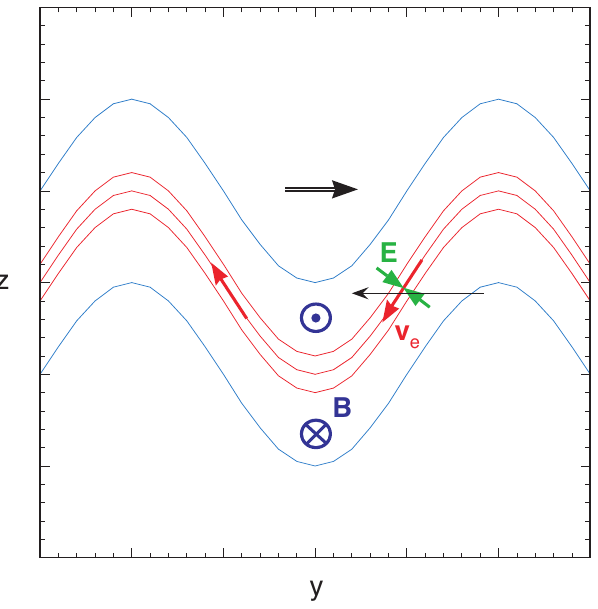
Fig. 2. Thin current sheet embedded in a wider current sheet which undergoes a kink mode propagating in y, as indicated by the double arrow. The red arrow indicates the fast electron drift in the em- bedded current sheet. The green arrows indicate the electric field associated with that drift. The blue circles with a cross and a dot, respectively, show the magnetic field direction, and the single black arrow indicates the motion of the Cluster satellites relative to the moving